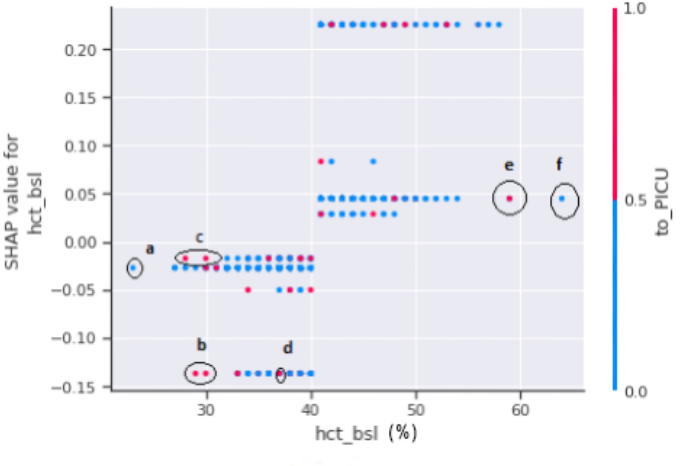
Figure 13. SHAP dependence plot between hct_bsl and to_PICU.